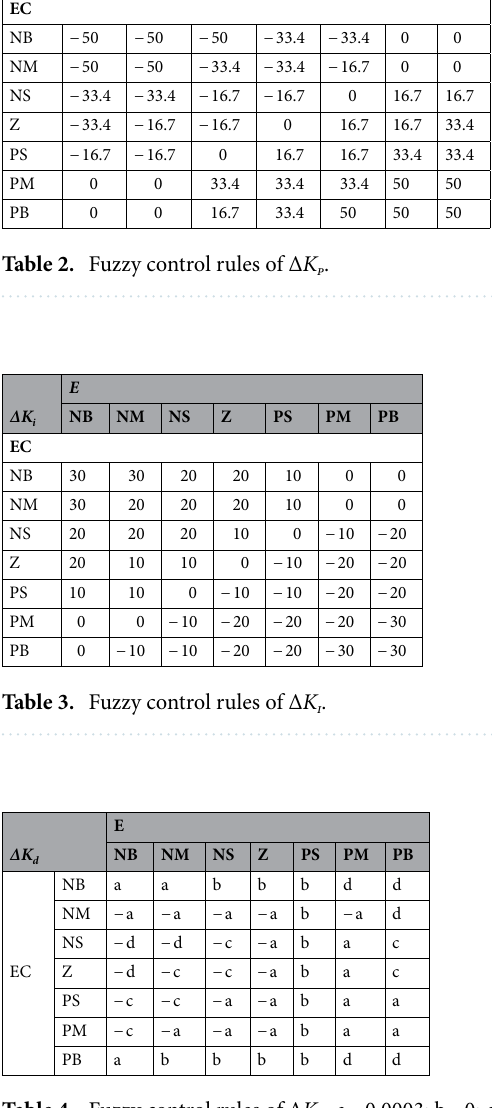
Table 4. Fuzzy control rules of Δ K d . a = 0.0003; b = 0; c = 0.0007; d =